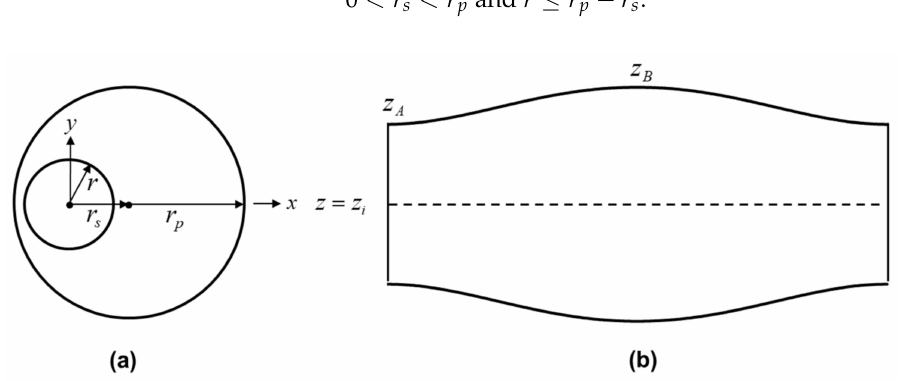
Figure 2. Cylindrical plane inside the sphere: ( a ) top view of plane at z = z i , ( b ) side view. The intersection plane lies between − π ≤ θ ≤ + π . The lower limit of the